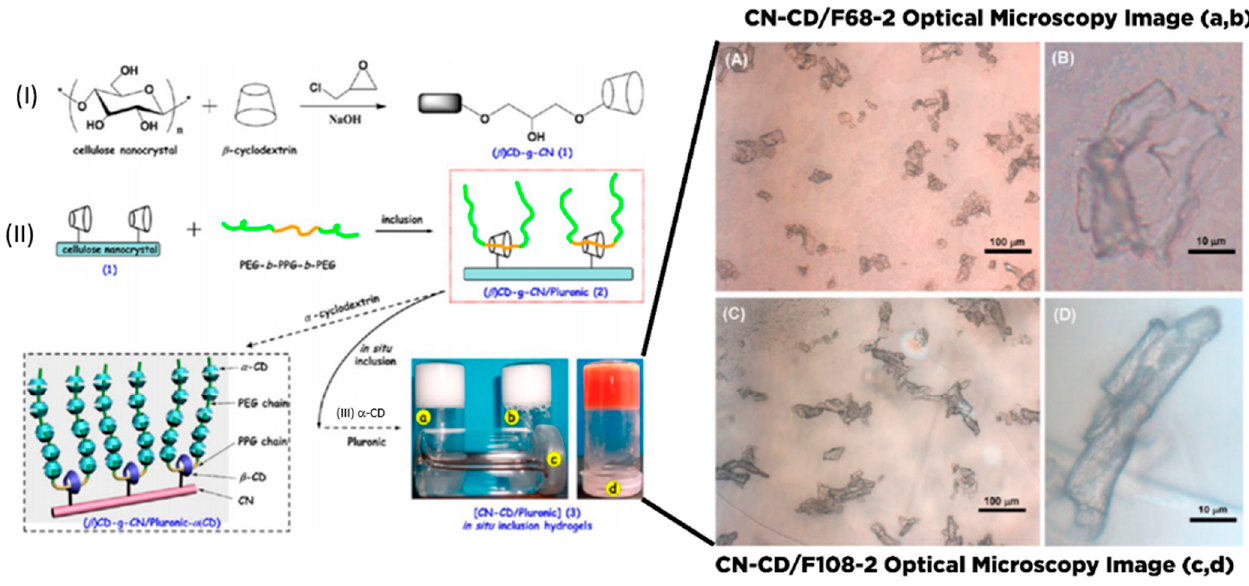
Figure 11. Construction pathway of ( I ) cellulose nanocrystal ( β )CD-g-CN grafted β -cyclodextrin; ( II ) complex inclusion between Pluronic polymers and ( β )CD-g-CN; ( III ) supramolecular hydrogels comprising an in situ inclusion between ( β )CD-g-CN/Pluronic and α -CD ( a ) hydrogel CN-CD/F68-2 and its and its morphological evidence, ( b ) hydrogel CN- CD/F108-2 and its morphological evidence, ( c ) water, ( d ) drug-loaded hydrogel CN-CD/F108-2-Dox. This figure is reprinted with permission from [178] . Copyright © 2013 American Chemical Society .